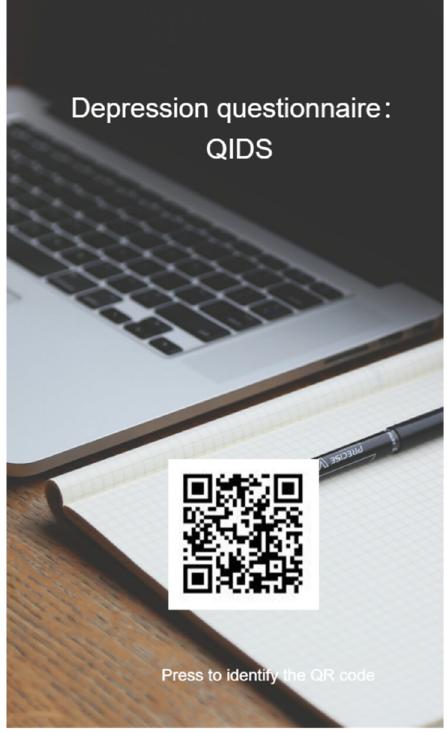
Figure 5. Example of the Questionnaire Star QR code poster.